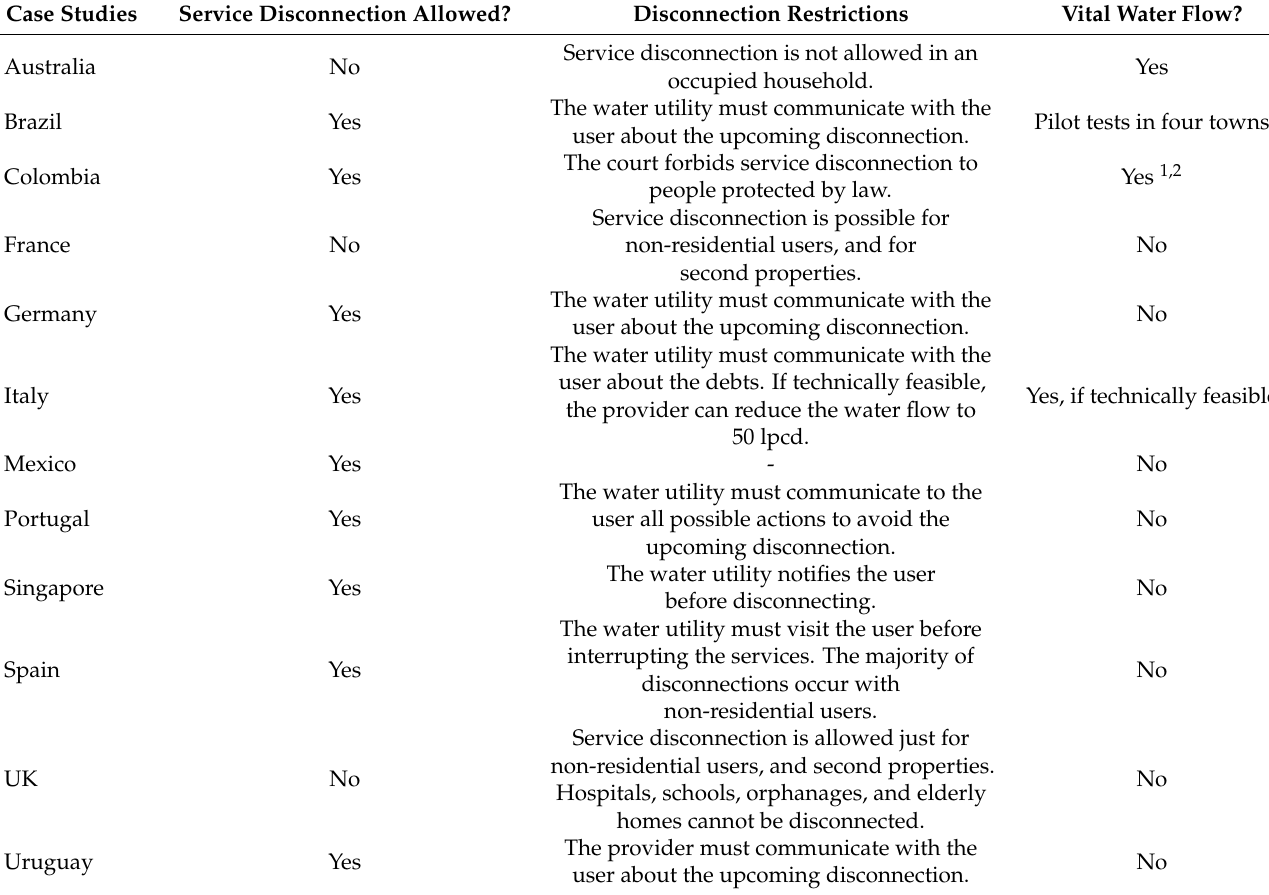
Table 3. Case study disconnection